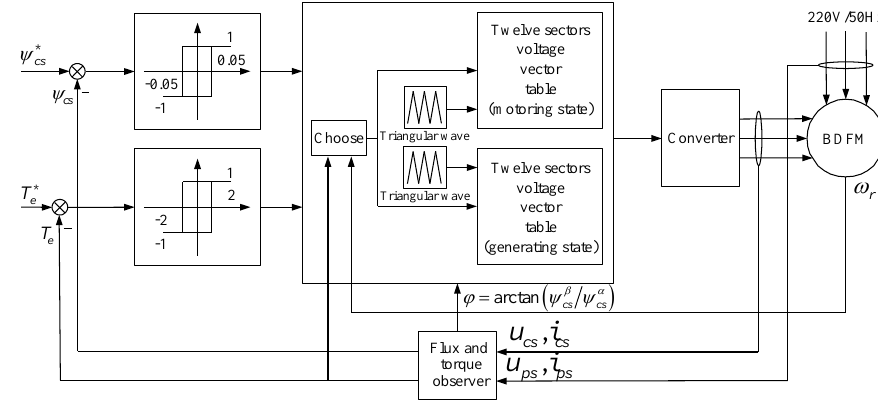
Figure 9. Control system of SVDTC.